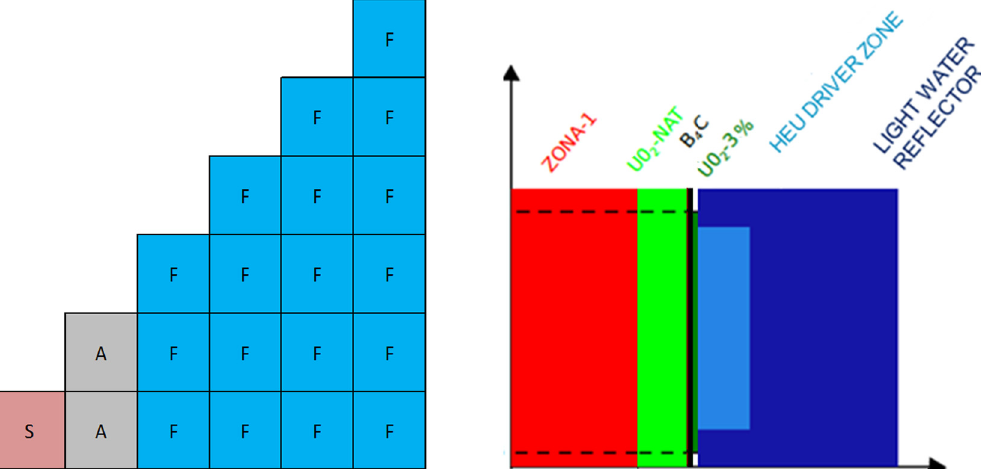
Fig. 5. APOLLO2 and ERANOS models of respectively the MAESTRO (left side) and ERMINE (right side) core con Table 3. Sensitivity coef fi cients (in %/%) on D r Isotope